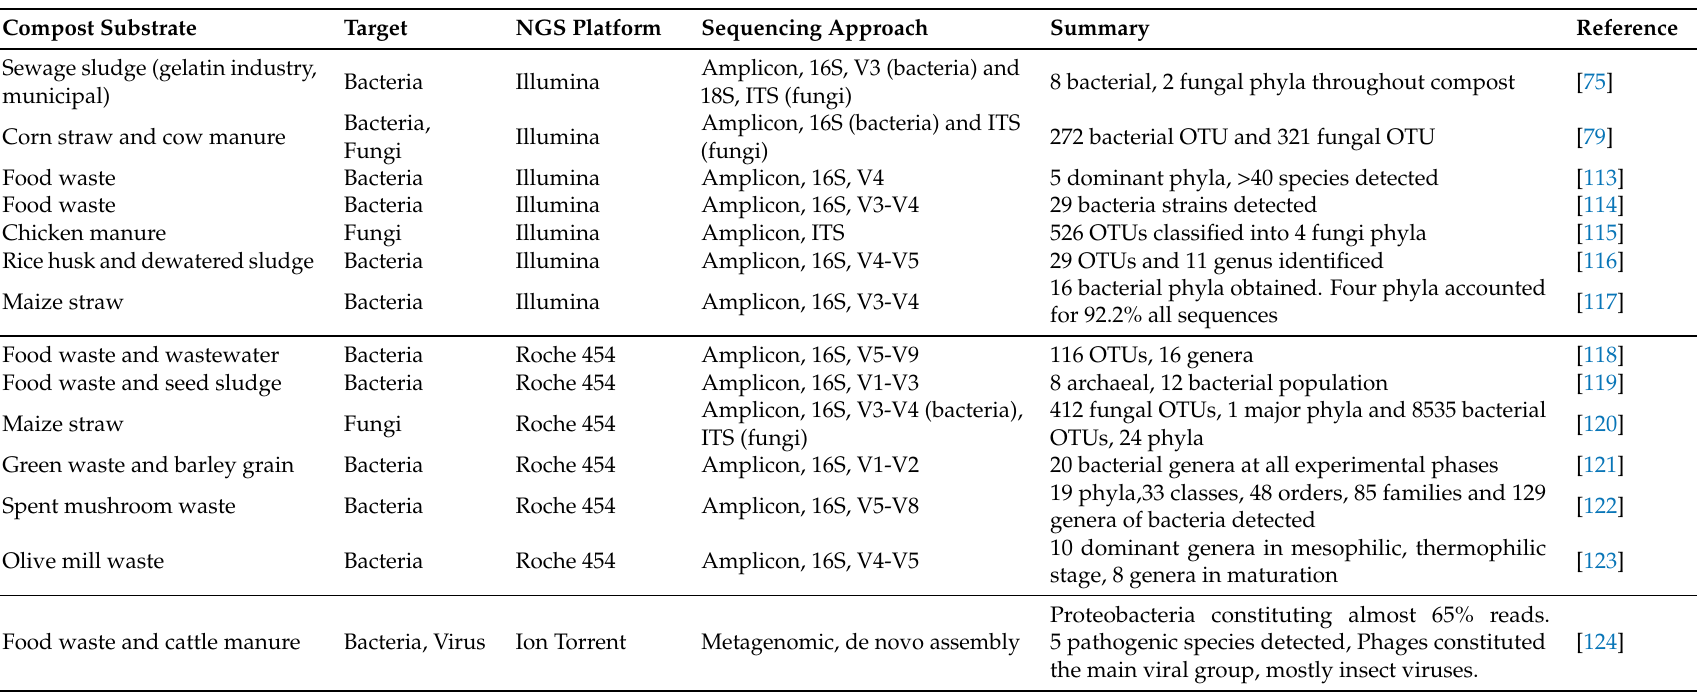
Table 8. Compost microbial community studies and the next generation sequencing (NGS) platform